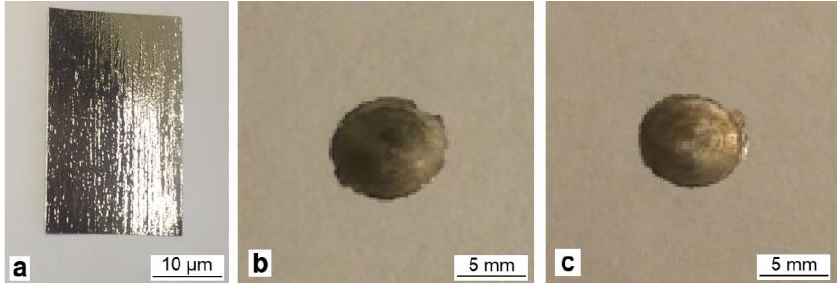
Figure 1. TiNiCu alloy samples in the initial state ( a ) and after deformation to n = 3 ( b ) and n = 5 ( c ).